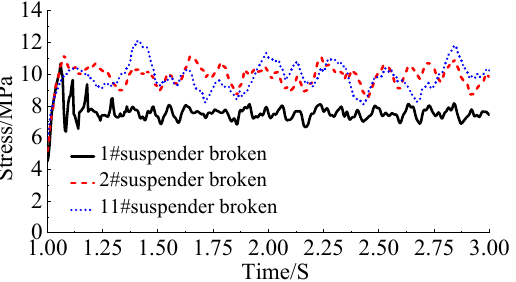
Figure 22. Longitudinal beam stress time history plot due to the suspender breakage.